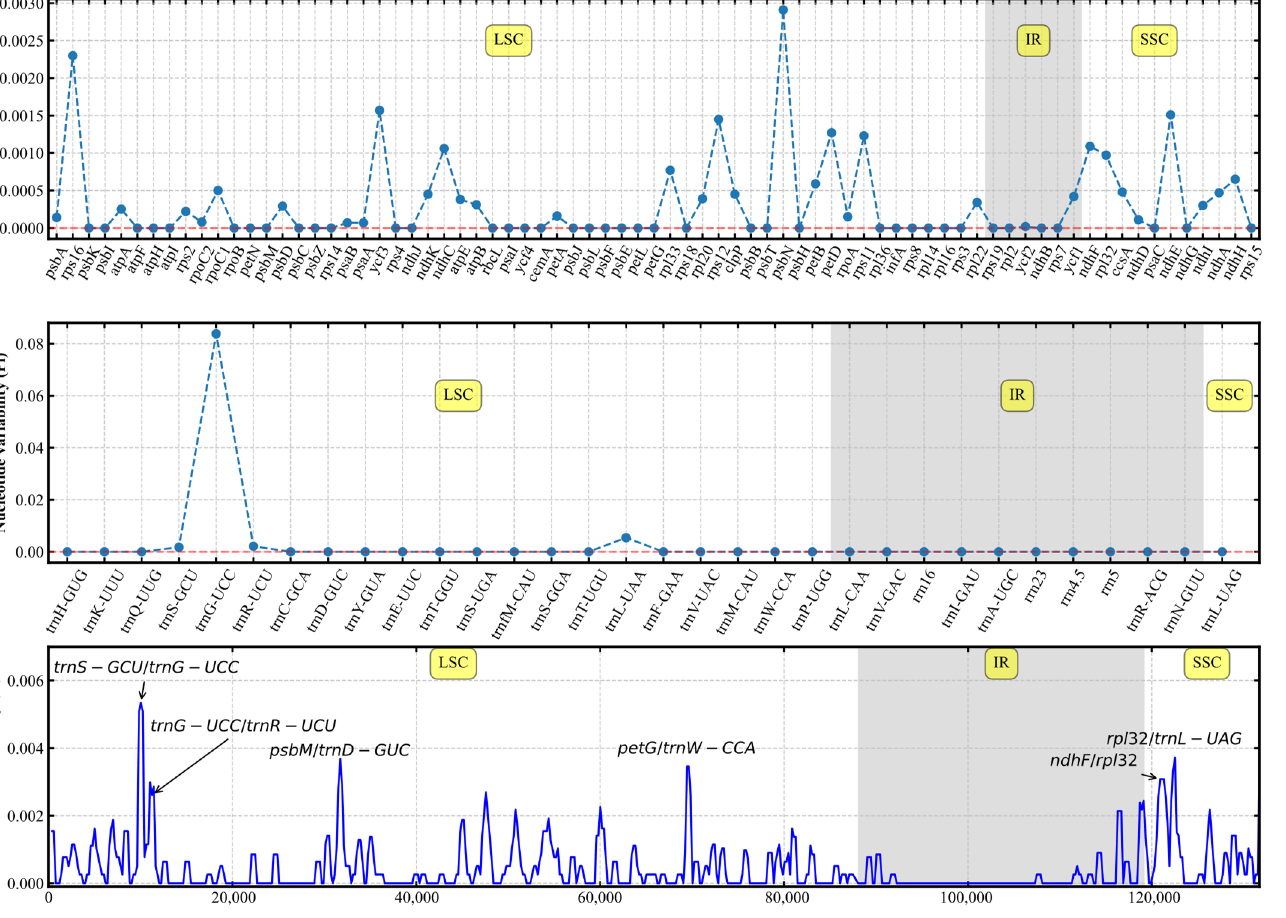
Figure 3. Gene nucleotide diversity (Pi) values of the 13 R. japonica. The 75 protein-coding genes ( A ) and 32 nonprotein-coding genes ( B ). X -axis, gene name; Y -axis, Pi value. ( C ) Six regions with the highest Pi values were masked based on alignment. Window length, 600 bp; step size, 200 bp. LSC, large single copy; IR, inverted repeats; SSC, small single copy.